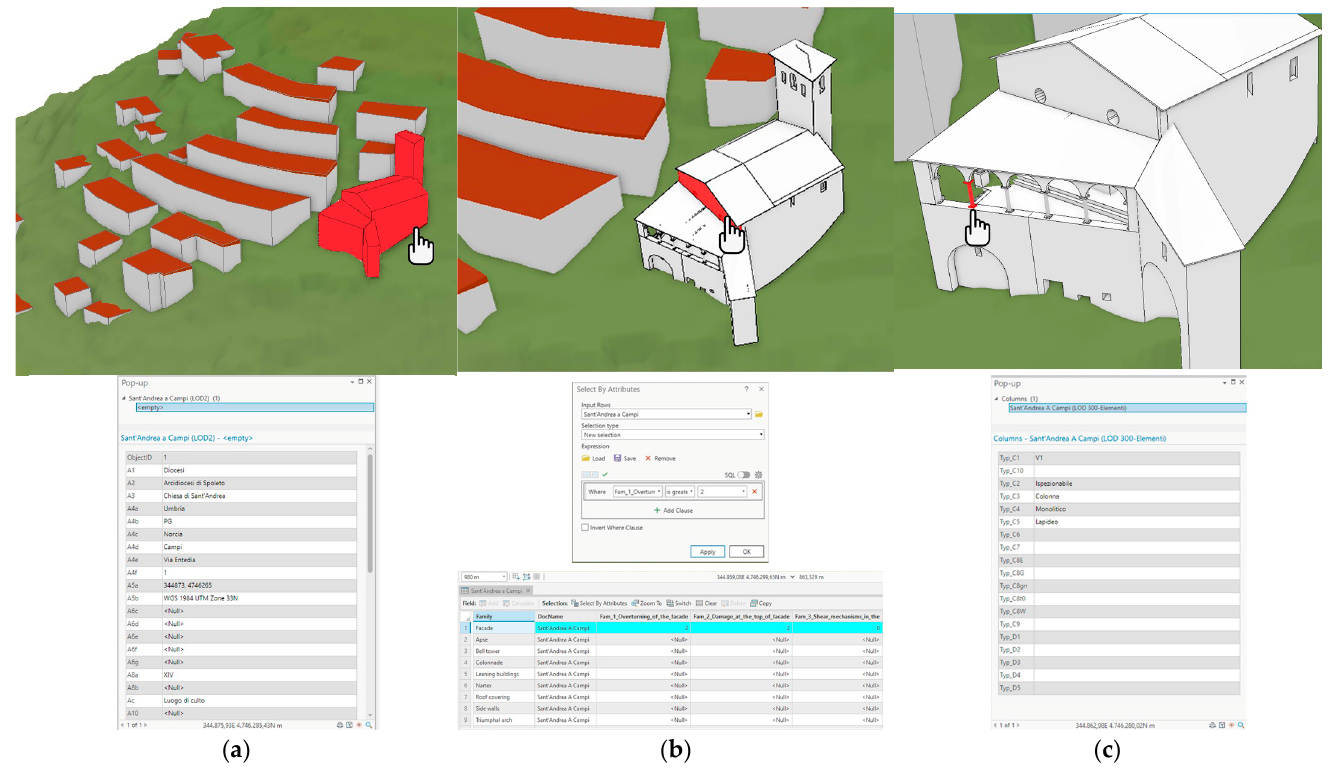
Figure 18. ( a ) Campi LoD2 GIS model: the ground from DSM, LoD 2 buildings from matching point cloud and 2D shape file and georeferenced LOD2 model of the church; ( b ) the LoD3 church model where macro-elements were modelled form BIM, and damage mechanism information was associated; and ( c ) the LoD4 church model where all elements were modelled, and information C and D were associated.